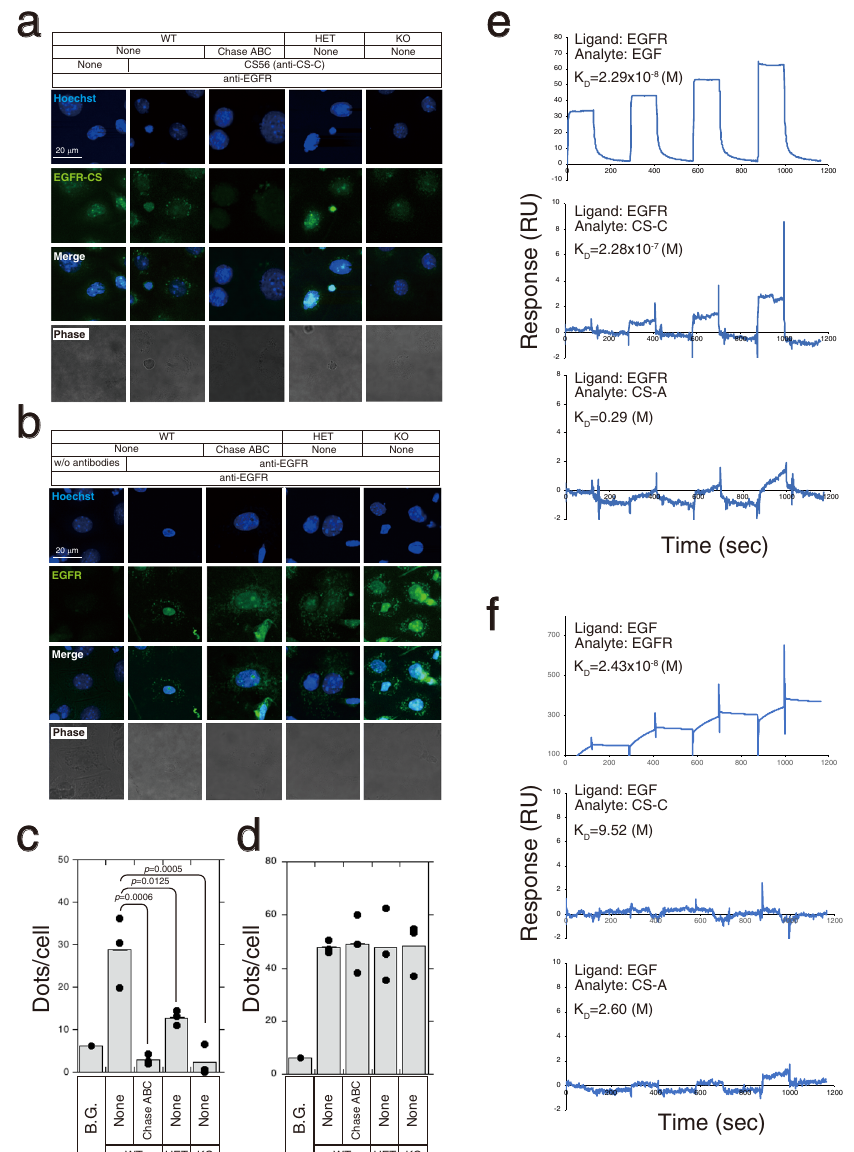
Fig. 6 CS-C directly interacts with EGFR in mouse keratinocytes. a Direct interactions between EGFR and CS-C (EGFR-CS) in primary C6st-1 WT, C6st-1 HE, and C6st-1 KO keratinocytes were examined by proximity ligation assay (PLA assay) using CS56 (anti-CS-C antibody) and anti-EGFR antibody. Keratinocytes digested with chondroitinase ABC were used as controls. b EGFR homodimers in primary keratinocytes were examined by PLA assay using anti-EGFR antibody. As a control, keratinocytes were digested with chondroitinase ABC, subjected to PLA assay. c The graph shows means ± S.D. of EGFR- CS signals (green dots)/cell counted in 7 – 12 cells from three independent experiments. d The graph shows means ± S.D. of EGFR homodimer signals (green dots)/cell counted in 7 – 12 cells from three independent experiments. Values are mean ± S.D. Statistical signi fi cance was determined using one-way ANOVA with Tukey ’ s HSD test. e The interaction of EGFR with EGF, CS-C, or CS-A was analyzed via SPR. f Similarly, the interaction of EGF with EGFR, CS- C, or CS-A was analyzed by